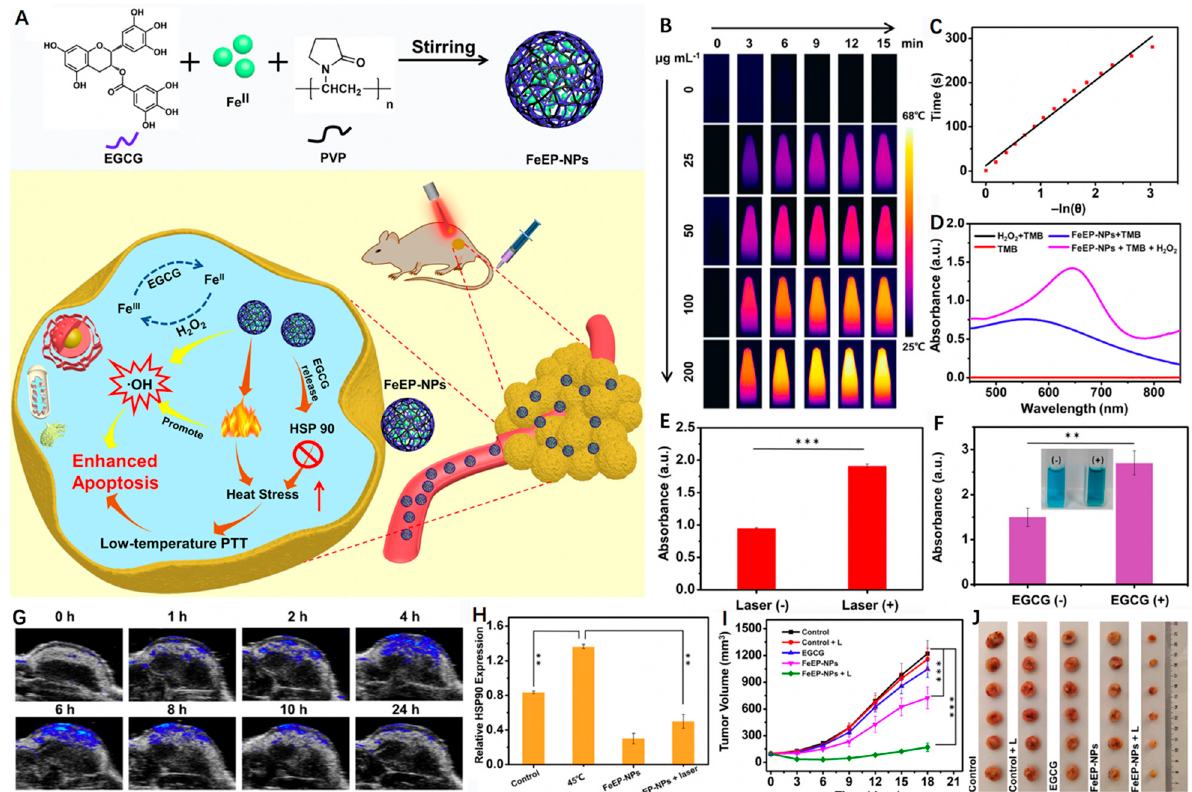
Figure 3. ( A ) Schematic detailing synthesis of the FeEP nanoplatform and illustrating its applications for mild PTT-enhanced CDT to promote tumor ablation. ( B ) Thermal images of FeEP with different concentrations (µg mL − 1 ) under 808 nm laser irradiation (1 W cm − 2 , 15 min). ( C ) Fitted linear relationship between − ln θ and time. ( D ) UV-vis absorbance spectra of tetramethylbenzidine (TMB), H 2 O 2 + TMB, FeEP + TMB and FeEP + H 2 O 2 + TMB. ( E ) UV-vis absorbance of TMB at the wavelength of 652 nm after being co-incubated with FeEP and H 2 O 2 together with and without laser irradiation. ( F ) UV-vis absorbance of TMB at the wavelength of 652 nm after incubation with Fe II + H 2 O 2 or Fe II + H 2 O 2 + EGCG. (*) p < 0.05, (**) p < 0.01 and (***) p < 0.001. ( G ) PA images of the tumor region from 4T1 tumor-bearing mice before and after intravenous injection of FeEP. ( H ) The relative HSP 90 expression level in 4T1 cells with different treatments. ( I ) The growth curves of tumor volumes of the mice after various treatments. (*) p < 0.05, (**) p < 0.01 and (***) p < 0.001. ( J ) Digital photography of the excised tumors from different mouse groups. Reprinted with permission from Ref. [63]. Copyright 2021, Elsevier Inc.